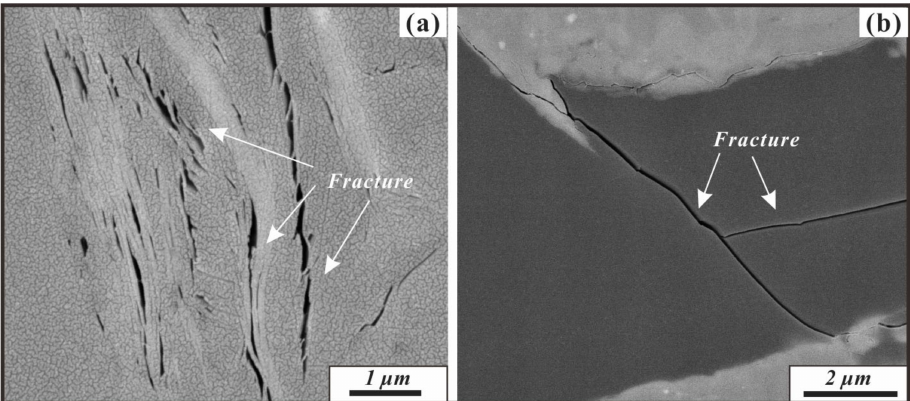
Figure 12. SEM images of micro-fractures in clay minerals ( a ) and organic matter ( b ) of the marine Taiyuan